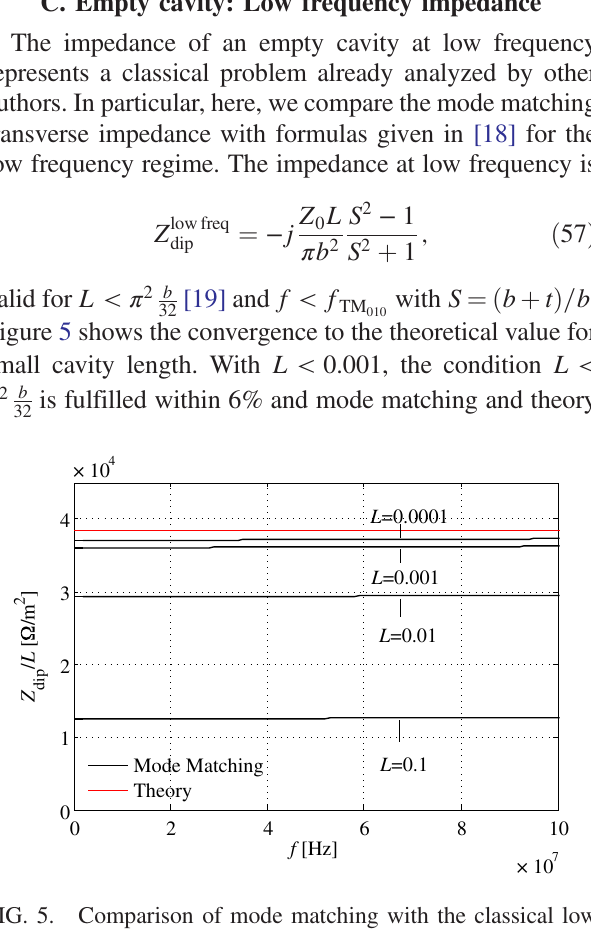
FIG. 5. Comparison of mode matching with the classical low frequency impedance in an empty cavity [18]. Mode matching parameters: b ¼ 5 cm, t ¼ 10 cm, L ∈ ð 10 − 4 ; … ; 0 . 1 Þ m, 10 − 12 S = m, β ¼ 1 σ c ¼